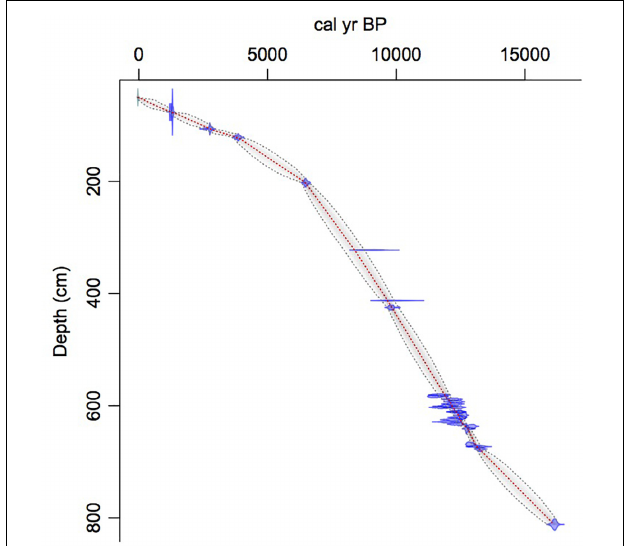
FIGURE 2 | Age-depth model. Red line indicates median age. Dotted lines indicate 95% confidence interval around the median age. Blue areas indicate calibration ranges for individual radiocarbon dates.